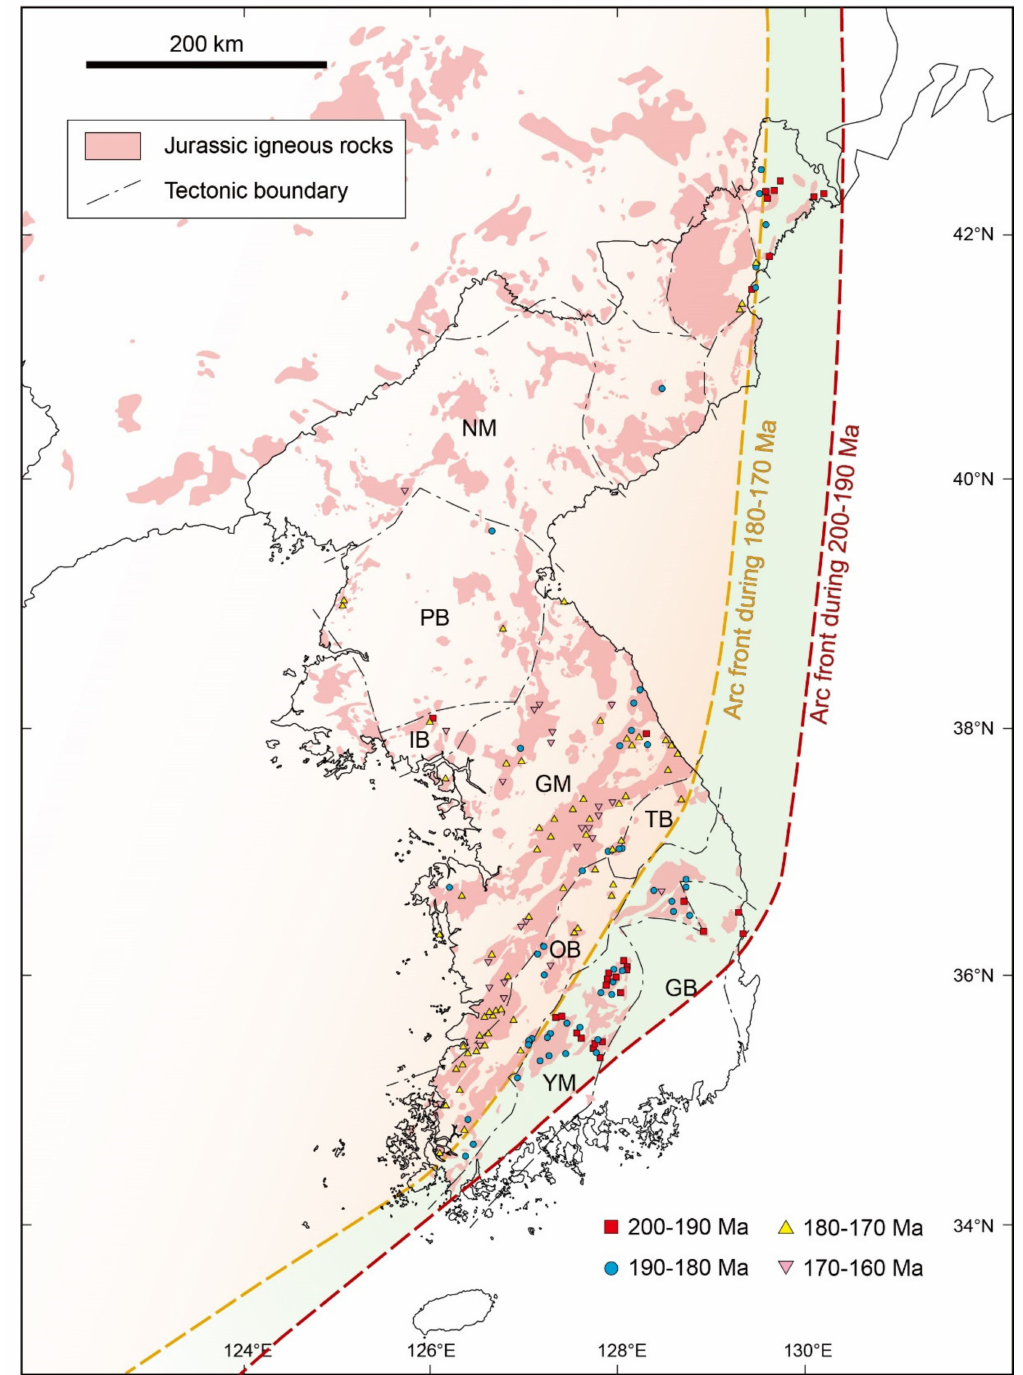
Figure 9. The map showing spatial distribution of the Jurassic igneous rocks in the Korean peninsula and northeastern China. Data sources are from [1–4,12]. The arc front was located in the YM during Early Jurassic (ca. 200–180 Ma) and moved northward to the southern margin of the Okcheon Belt during ca. 180–170 Ma, and then to the northern margin of the Okcheon Belt during ca. 170–160 Ma. NM: Nangrim Massif; PB: Pyeongnam Basin; IB: Imjingang Belt; GM: Gyeonggi Massif; OB: Okcheon Belt; TB: Taebaeksan Basin; YM: Yeongnam Massif; GB: Gyeongsang